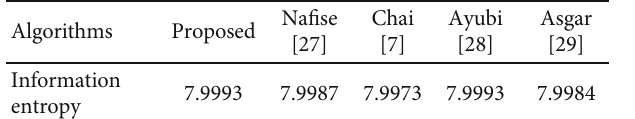
Table 8: Information entropy comparison of Lena.